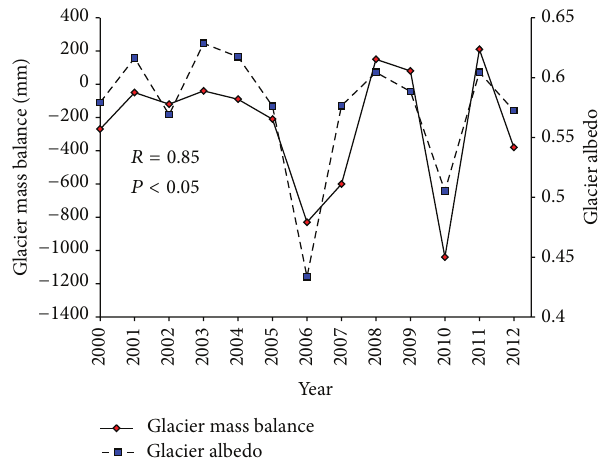
Figure 9: Annual variations of glacier mass balance, glacier albedo in summer during